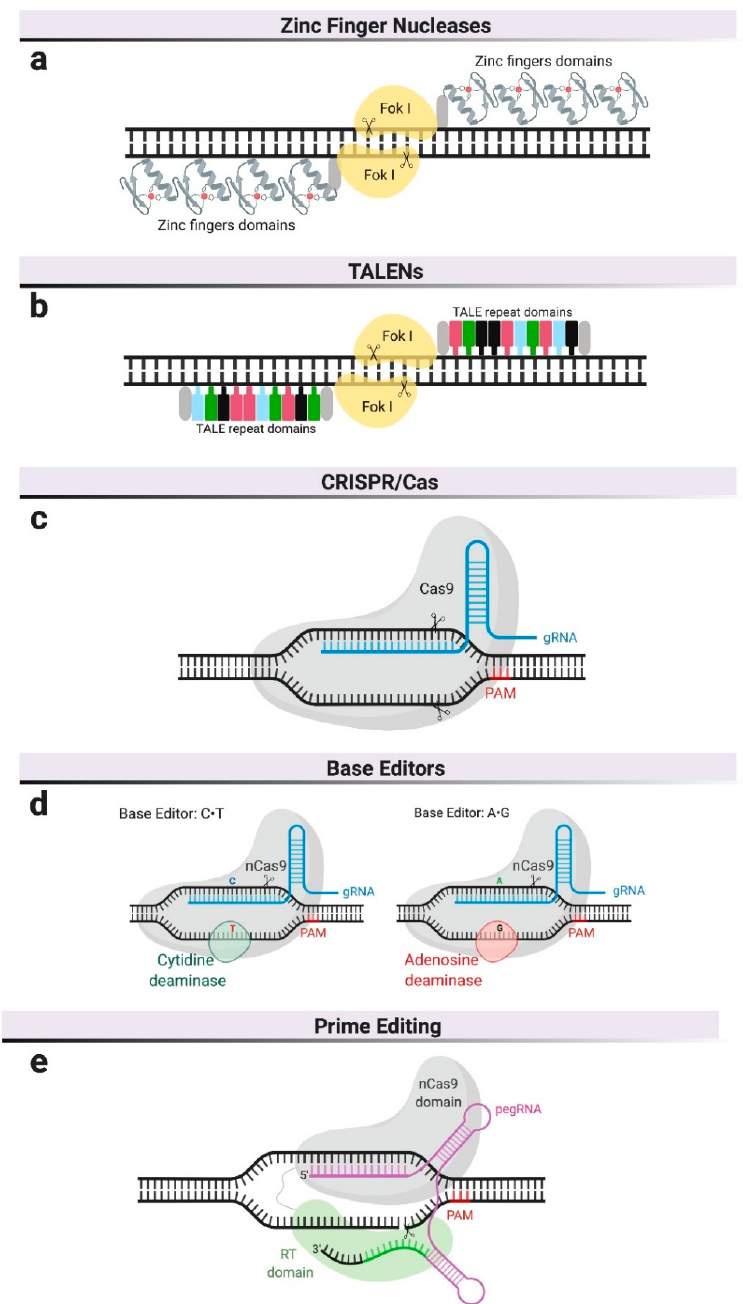
Figure 1. Genome editing platforms. ( a ) Zinc finger nucleases—zinc finger domains are fused to the restriction endonuclease, FokI, and require dimerization. ( b ) Transcription activator-like effector nucleases (TALENs) also use FokI as endonuclease but their DNA-binding domain is composed of repeats derived from transcription activator-like effectors (TALEs). ( c ) Clustered, regularly interspaced, short palindromic repeat (CRISPR)/Cas9 system uses a guide RNA (gRNA) to recognize specific DNA sequences and a Cas9 nuclease to cleave both DNA strands. DNA cleavage only occurs if the gRNA is adjacent to a Protospacer Adjacent Motif (PAM). ( d ) Base editors use inactive Cas9 or Cas9 nickase (nCas9), complexed with base-modifying enzymes and a gRNA. ( e ) Prime editors use a Cas9 nickase fused to reverse transcriptase and are complexed with pegRNA, which serves as gRNA and as template for reverse transcription.